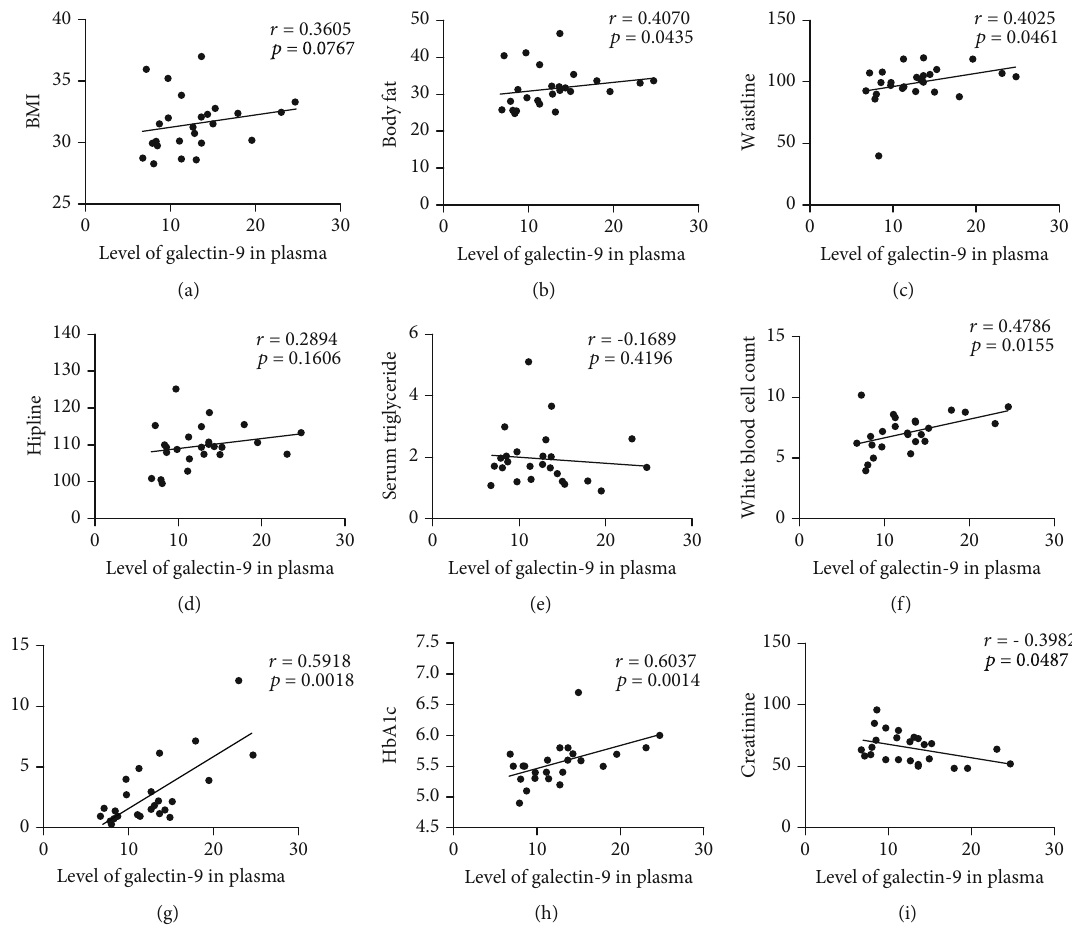
Figure 3: Correlation analyses between the galectin-9 expression and clinical indicators in obesity patients. Correlation analysis of plasma galectin-9 and BMI (a), body fat percentage (b), waistline (c), hipline (d), triglyceride (e), white blood cell count (f), CRP (g), HbA1c (h), and creatinine